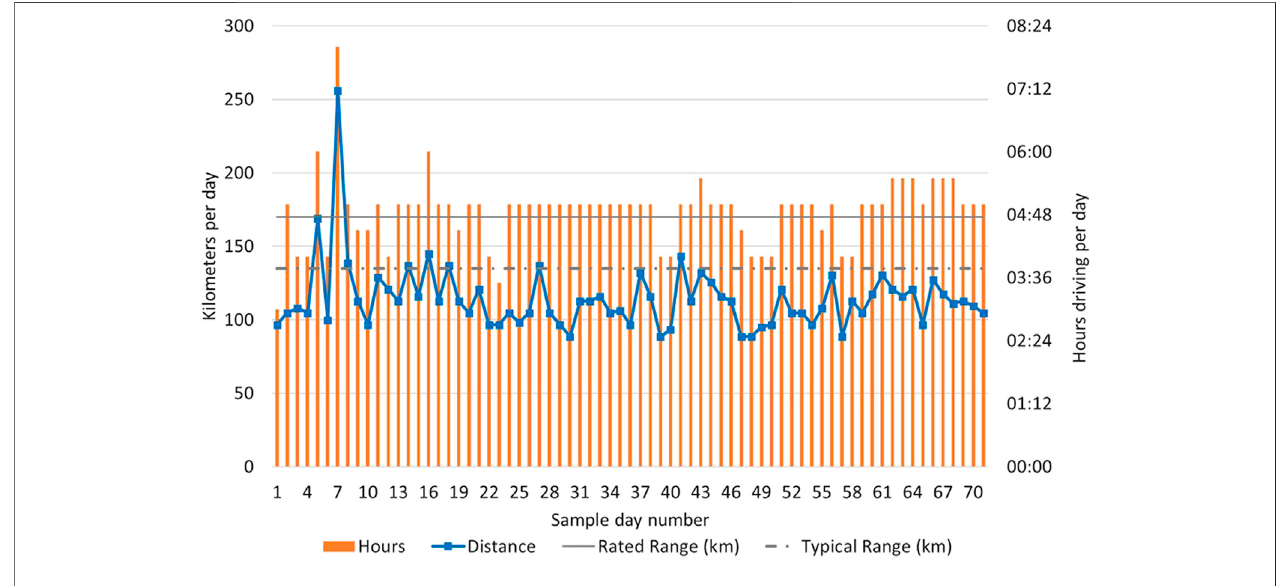
FIGURE 8 | Operational time and distance traveled for each of 71 days of the Solar Taxi